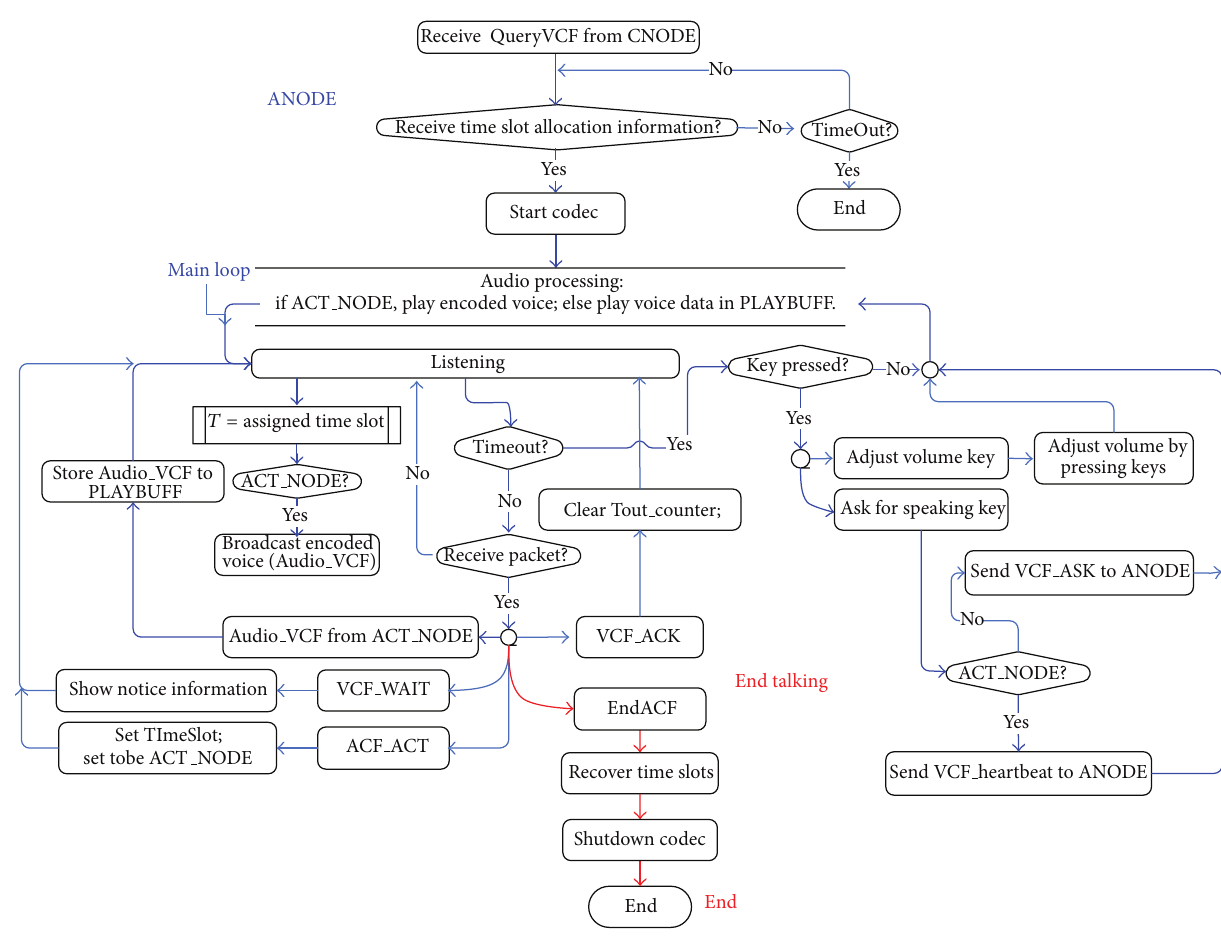
Figure 17: VCF communication